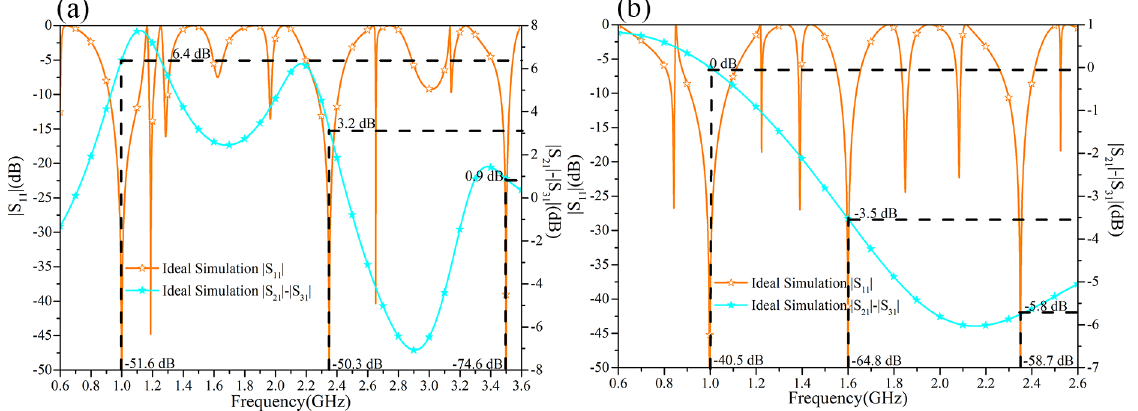
Fig 4. The ideal simulation results of the two comparative examples of the TTPD. (a) Comparativeexamplewith same power divisionratio and different operatingfrequency (1 GHz, 2.35 GHz, 3.5 GHz). (b) Comparative examplewith different power division ratio (0 dB, -3.5 dB, -5.8 dB) and same operatingfrequency.